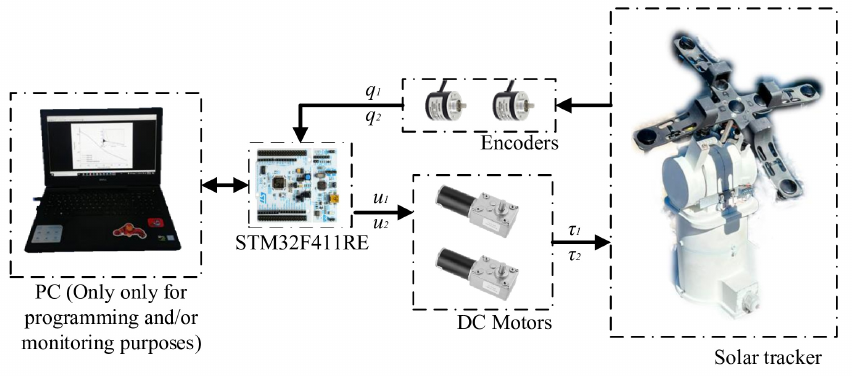
Figure 11. Block diagram of the experimental robotic